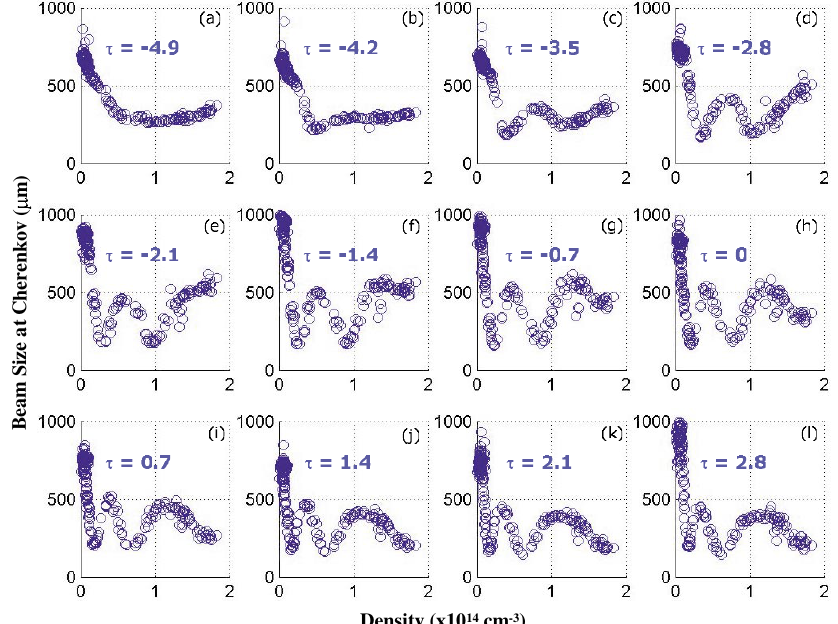
FIG. 8. (Color) The spot sizes of individual Cherenkov time slices (read left-right, top- bottom) from the analysis of Fig. 7 for ambient plasma densities up to 1 : 8 (cid:3) 10 14 cm (cid:4) 3 . Graph (a) shows the weak focusing force, which dominates the first head slice. Beginning at graph (b) the slices are in the linear portion of the chirp. Graphs (i)–(l) are in the blowout regime, since the focusing force is no longer